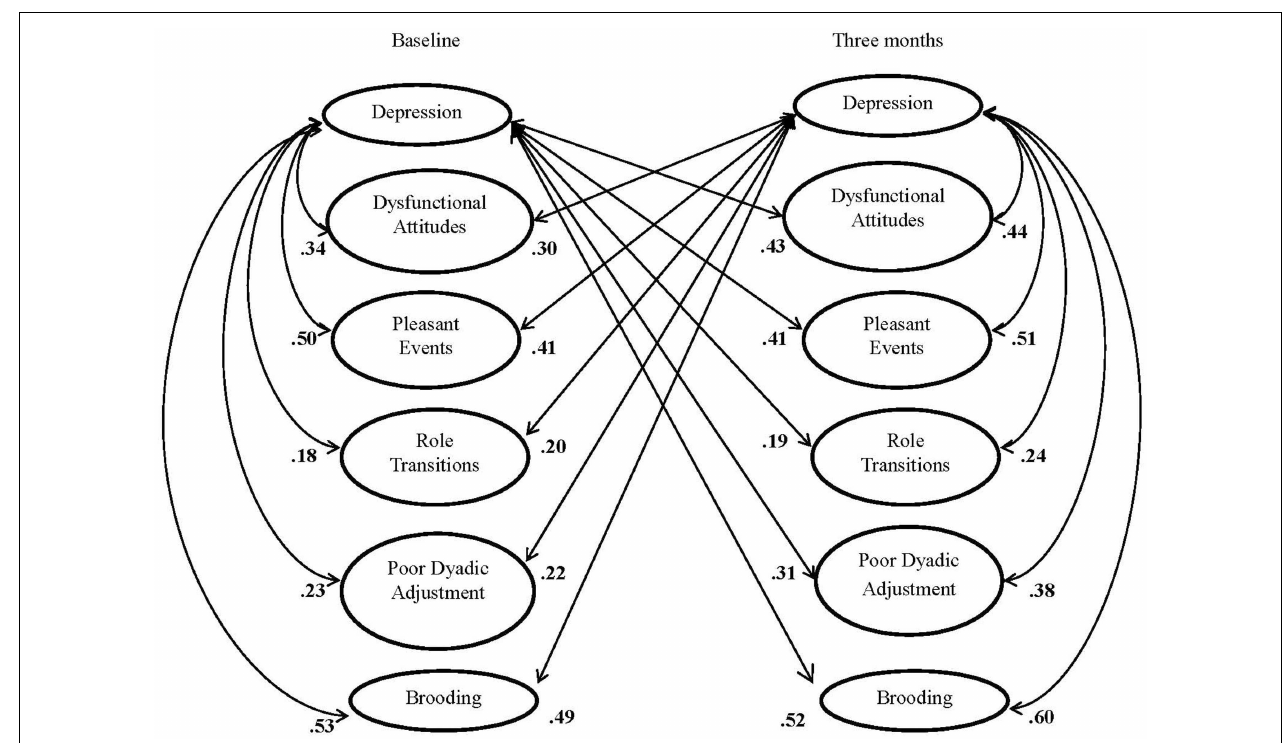
FIGURE 1 | Cross lagged correlations between depression, vulnerabilities, and rumination for baseline and 3 months. All correlations are significant at ** p < 0.001.